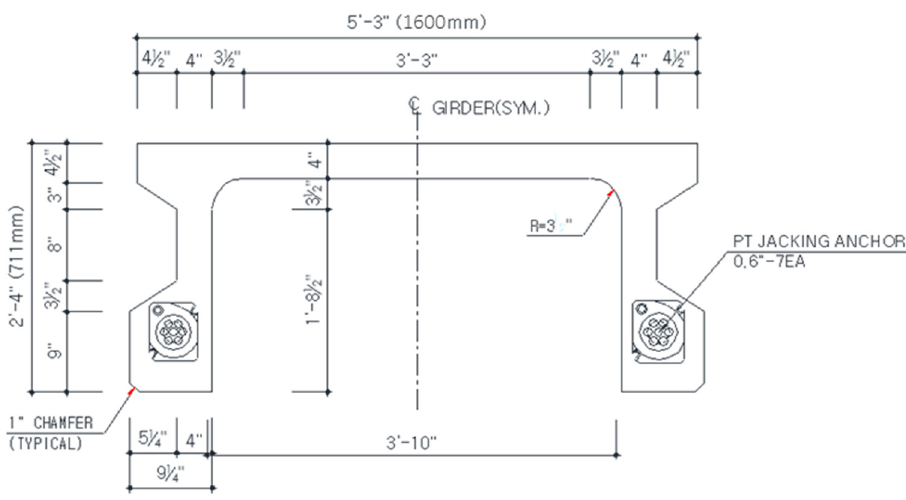
Figure 6. Hawkeye Bridge pi-girder cross-section design.